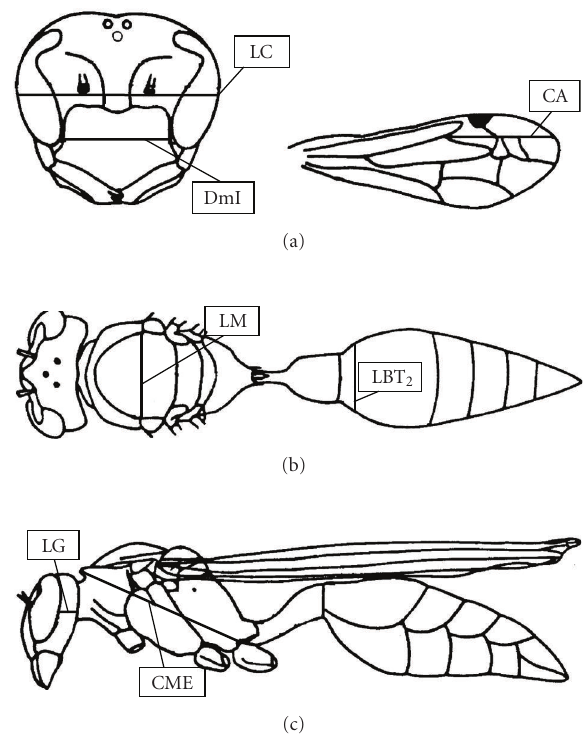
Figure 1: Representative measures for morphometric analyses: head width (LC); minimum interorbital distance (DmI); gena width (LG); mesoscutellar width (LM); alitrunk length (CME); basal width of tergite II (LBT2); partial length of the forewing (CA). Modified by Shima et al.